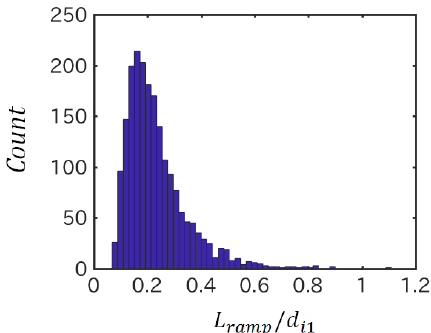
Figure 6. Histogram of the spatial size of the shock ramp for 8 points in position (y/d i1 = 0 : 0 . 75 : 5 . 25 ) × 251 points in time ( ω ci1 t = 4 : 0 . 032 : 12) in the run with m i /m e = 625 and the large simulation domain. The spatial size of the shock ramp is approx- imated by the gradient of the shock magnetic field normalized by B y, max − B y 01